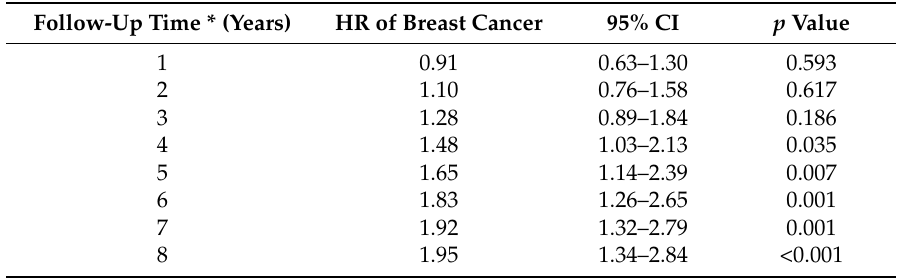
Table 2. Breast cancer hazard ratio of HRT users versus non-users by Cox proportional hazards model, adjusted for birth